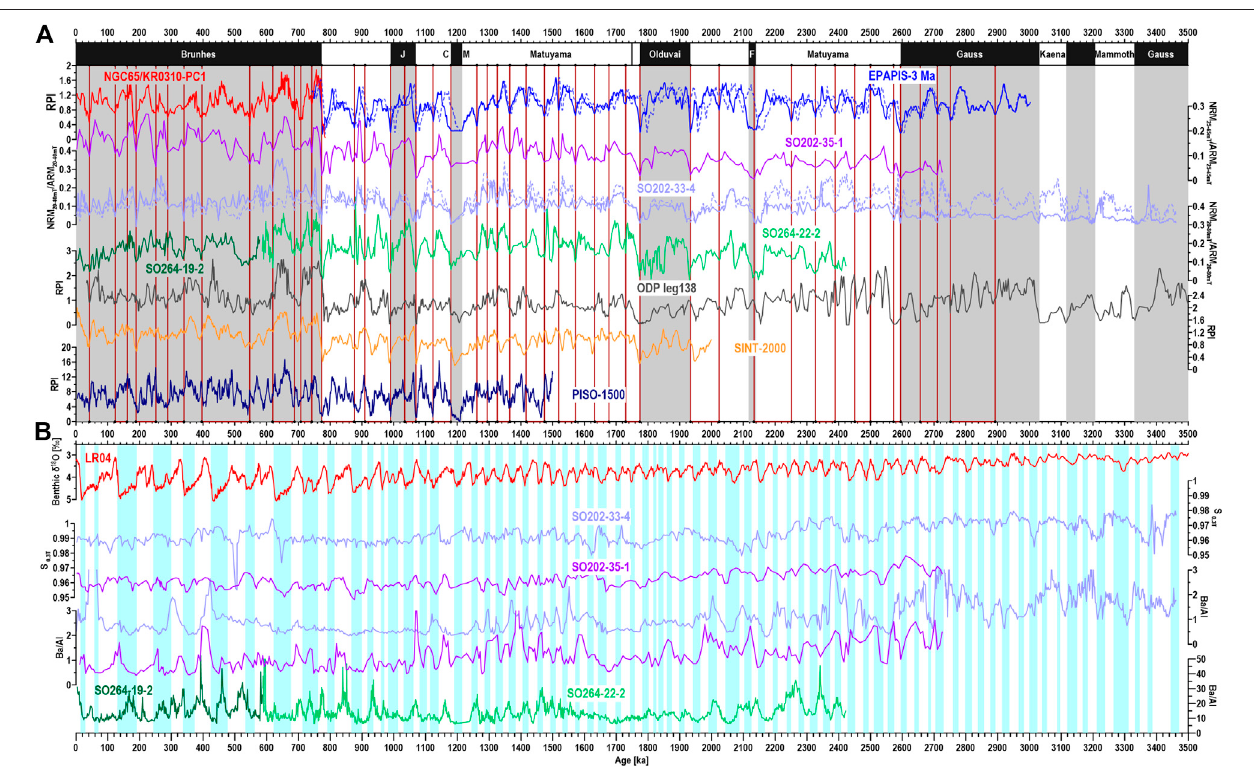
FIGURE 11 | (A) Tuned RPI records of cores SO202-35-1 (dark purple), SO202-33-2 (light purple), SO264-19-2 (0 – 580 ka, dark green), SO264-22-2 (580 – 1,800 ka, light green), target core NGC65/KR0310-PC1 (0 – 780 ka, red; Yamazaki and Kanamatsu, 2007), EPAPIS-3Ma stack (773 – 3,000 ka; dotted blue line: original record, solid blue line: after adjustment to GPTS 2020; Yamazaki and Oda, 2005), ODP leg 138 sites 848, 851, 852 (grey line; Valet and Meynadier, 1995), SINT-2000 (deep and light orange lines Guyodo and Valet, 1999; Valet et al., 2005), PISO-1500 (dark blue line; Channell et al., 2009) for the age period 0 – 1,800 ka. Black (white) bars at the top indicate normal (reverse) polarity (sub)chrons. Magnetostratigraphic abbreviations: J — Jaramillo Subchron, CM — Cobb Mountain Subchron, G — Gauss Chron. (B) LR04 stack (red curve; Lisiecki and Raymo, 2005), S 0.3T records of cores SO202-33-4 (light purple) and SO202-35-1 (dark purple), Ba/Al records of cores SO264-19-2 (dark green) and SO202-22-2 (light green). Glacial MIS stages are marked in light blue (1,700-3,500 ka).